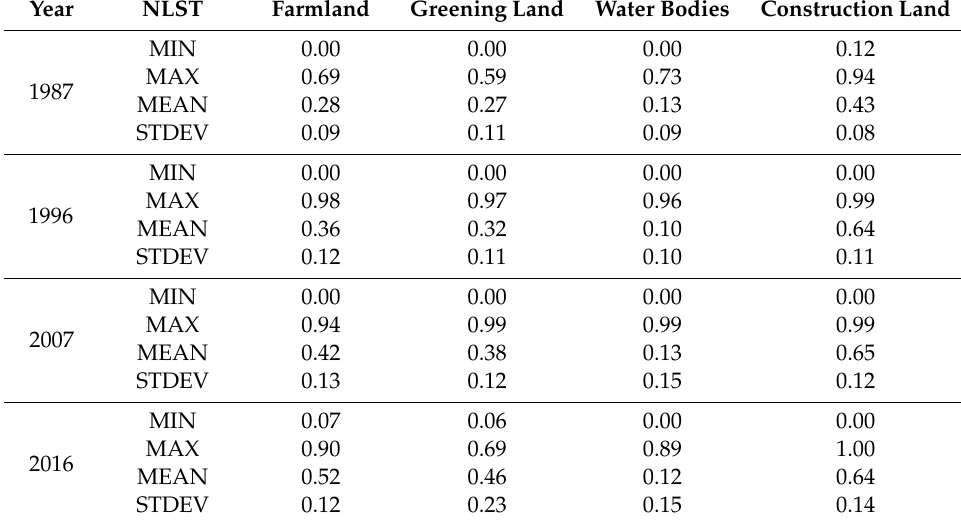
Table 8. Normalized land surface temperature in di ff erent LULC categories, minimum (MIN), maximum (MAX), average (MEAN) and standard deviation (STDEV).